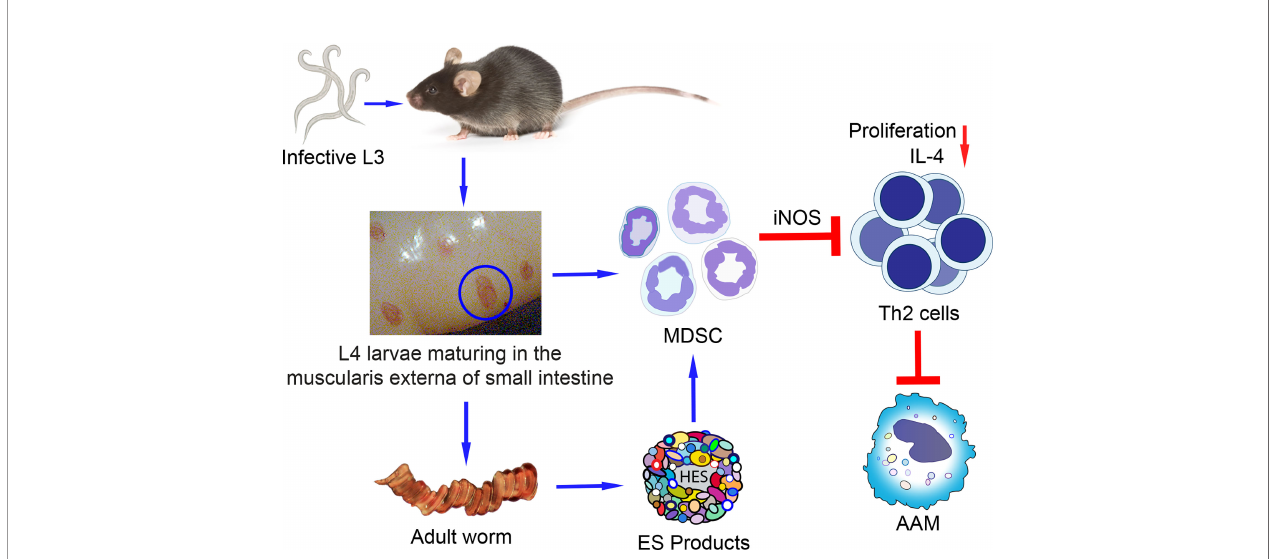
FIGURE 1 | Proposed model of MDSC differentiation and expansion induced by the GI nematode using H. polygyrus bakeri as an example. Mice are infected with H. polygyrus bakeri by ingestion of infective stage 3 larvae (L3) which develop into stage 4 larvae (L4) in the muscularis externa of the small intestine. L4 eventually mature into male and female adult worms that mate and produce eggs which are shed in the feces and contaminate the soil. Larvae and adult worms induce the differentiation and expansion of MDSC in the infected intestine and systemically in distal tissues. The MDSC suppress the proliferation of CD4 + Th2 cells and their IL- 4 secretion in response to parasite-speci fi c antigens. Decreased levels of IL-4 result in sub-optimal numbers of alternatively activated macrophages (AAM) important in expelling adult worms and in immunity to reinfection. ES (HES from H. polygyrus bakeri ) produced by adult worms or larvae may also induce